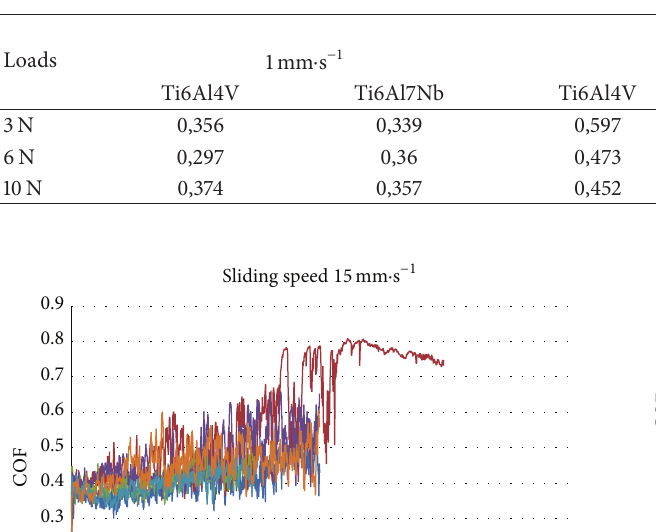
Table 5: Mean coefficient of friction of Ti-6Al-4V and Ti-6Al-7Nb alloy versus sliding distance under different conditions of loads and sliding speeds.